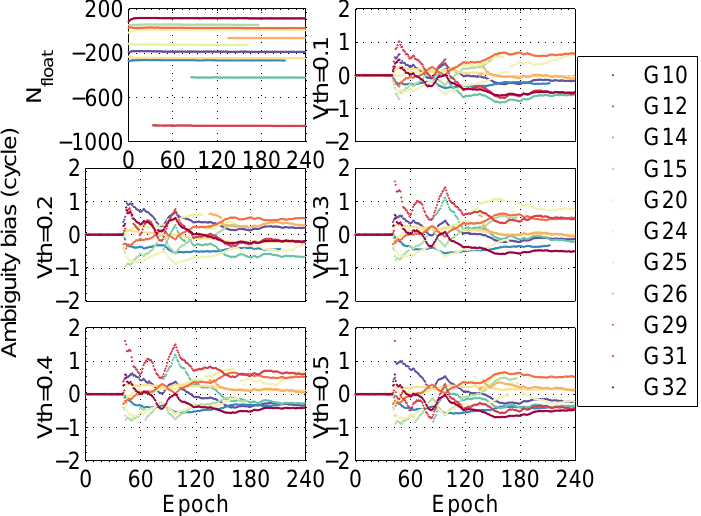
Figure 7. Ambiguity bias in different thresholds at station CNMR in the post-processing PPP.